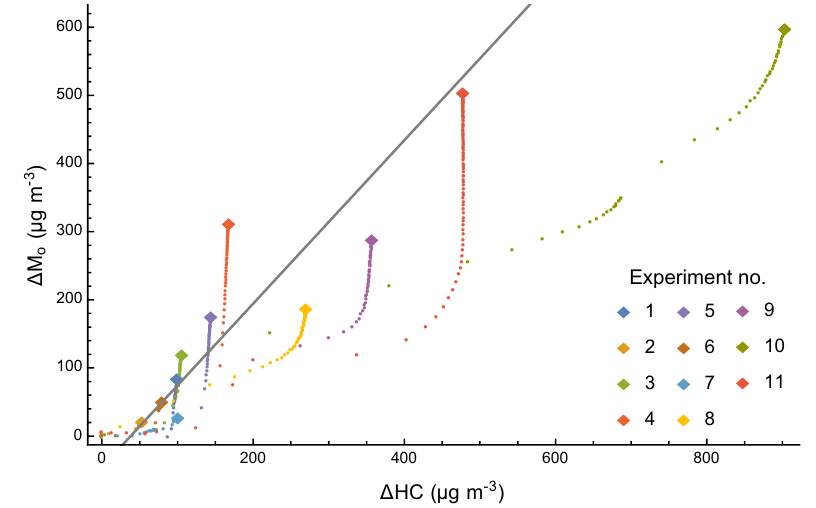
Figure 13. Time-dependent SOA growth curves. The grey line is a fitted one-parameter fit yield curve.